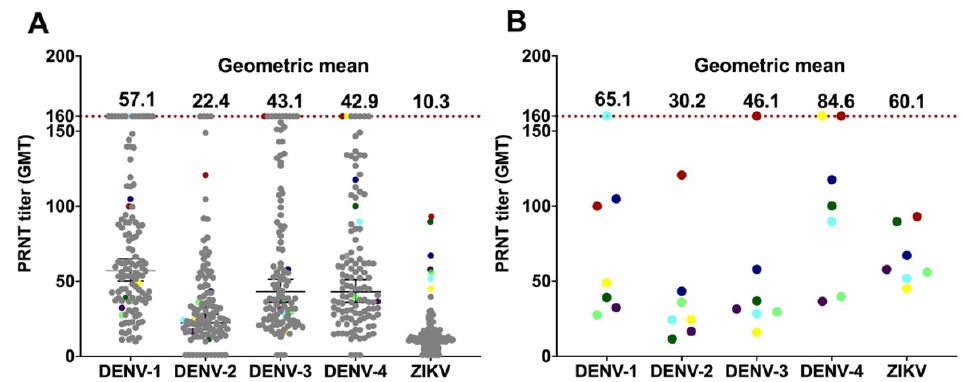
Figure 7. Neutralizing antibody (NAb) titers for ZIKV and DENV at PRNT 90 ( n = 116). ( A ) ZIKV NAb titers and corresponding DENV NAb titers were plotted to show dengue infection background. ( B ) For seven serum samples that had ZIKV NAb titers > 40, the DENV NAb titers were plotted